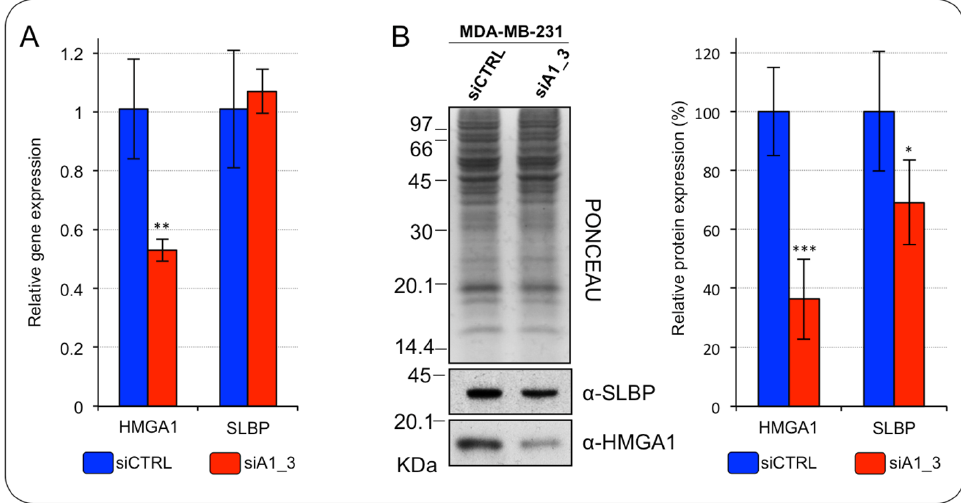
Figure 6. HMGA1 regulates the SLBP expression level in MDA-MB-231 cells. ( A ) RT-qPCR analyses of HMGA1 and SLBP in MDA–MB–231 cells silenced for HMGA1 (siA1_3) or treated with control siRNA (siCTRL). Bars indicate the mean. Standard deviations are shown ( n = 4). Statistical significance was assessed with Student’s t -test (*: p ≤ 0.05; **: p ≤ 0.01; ***: p ≤ 0.001). ( B ) Western blot analyses of HMGA1 and SLBP protein expression in MDA–MB–231 cells silenced for HMGA1 (siA1_3) or treated with control siRNA (siCTRL). Representative WB analyses are shown together with red ponceau stained membrane as normalization. The histogram graph on the right refers to densitometric analysis of western blot (siCTRL versus siA1_3). Bars indicate the mean. Standard deviations are shown ( n = 4). Statistical significance was assessed with Student’s t -test (*: p ≤ 0.05; **: p ≤ 0.01; ***: p ≤